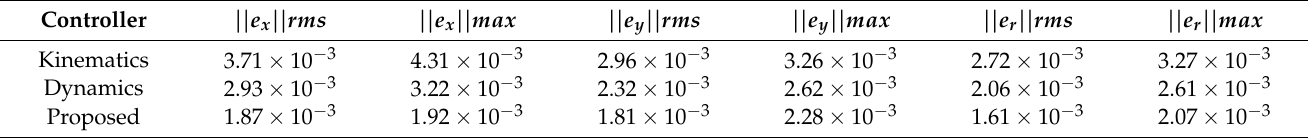
Table 3. The inverted octagonal type trajectory tracking error values for three